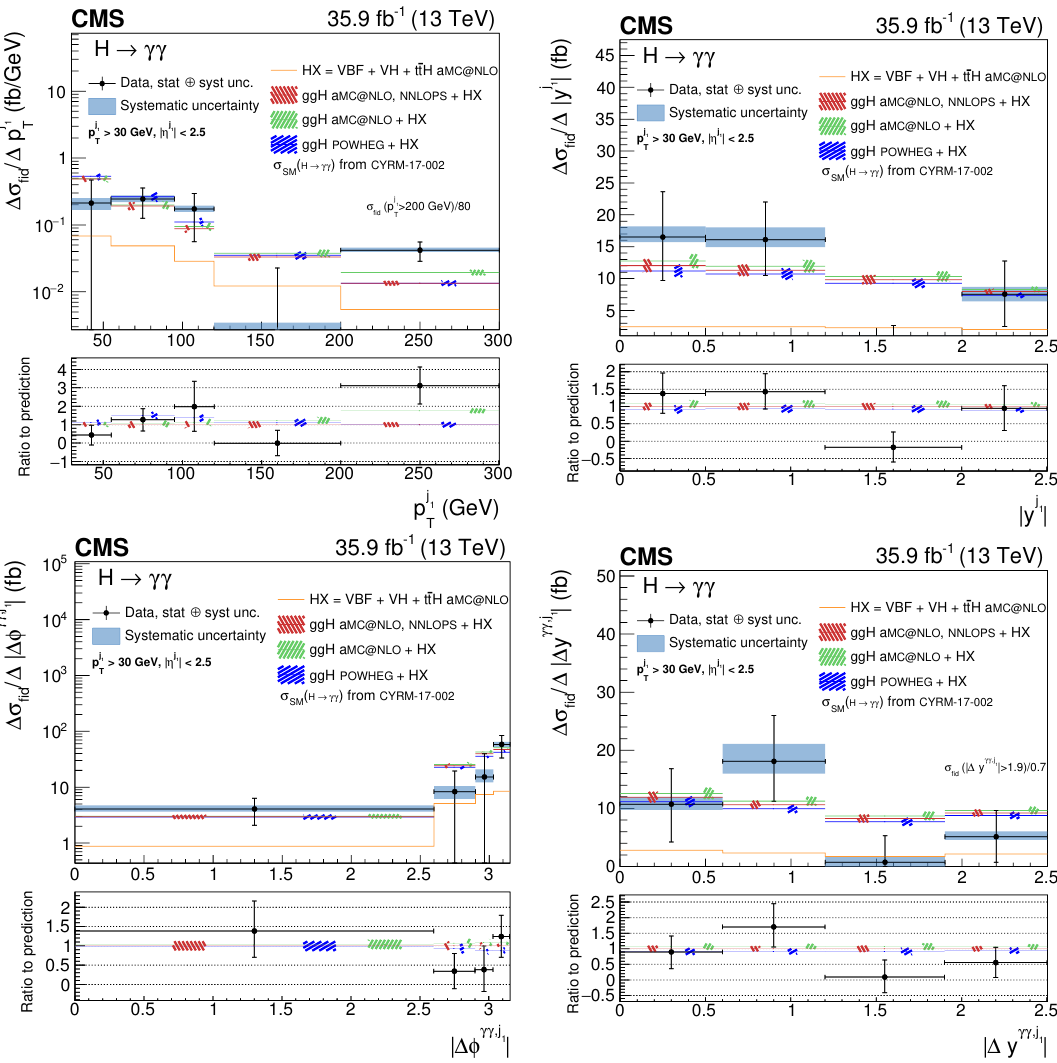
Figure 5 . Measurement of the di(cid:11)erential cross section (black points) as functions p j 1 j (cid:1) (cid:30) (cid:13)(cid:13);j 1 j , and j (cid:1) y (cid:13)(cid:13);j 1 j . The error bars indicate 1 standard deviation uncertainty. The systematic component of the uncertainty is shown by the blue band. The measurements are compared to di(cid:11)erent simulation programs (histograms) with their uncertainties (hatched areas), all normalized to the same theoretical predictions from ref. [13]. When the last bin of the distribution is an over(cid:13)ow bin, the normalization of the cross section in that bin is indicated in the (cid:12)gure.